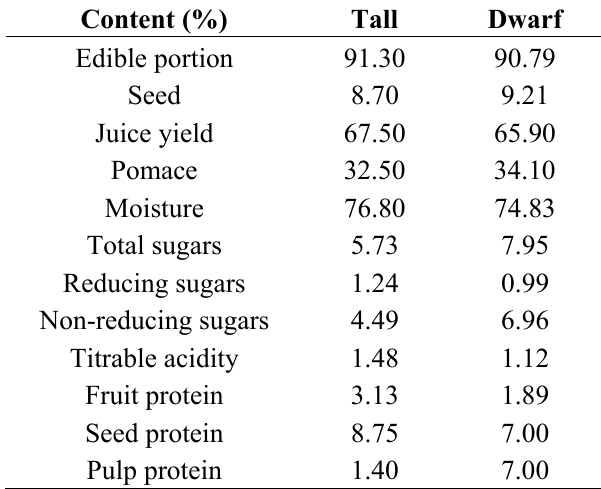
Table 1. Characteristics of tall and dwarf types of Grewia asiatica